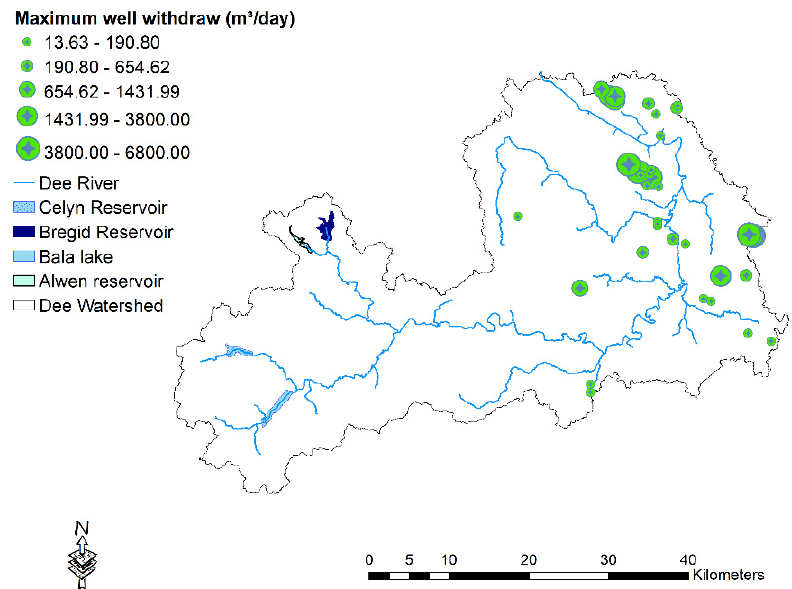
Figure 11. Location of the license withdraw wells used in the MODFLOW model.